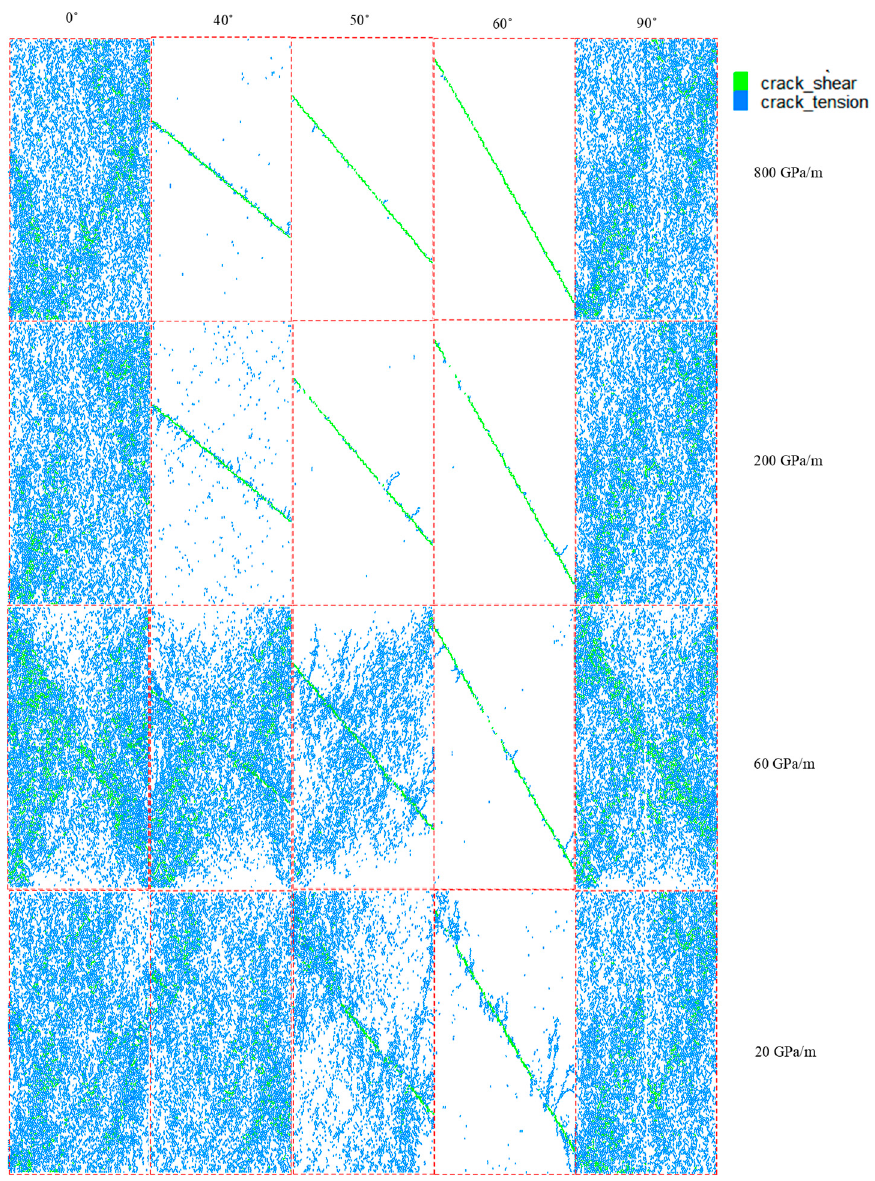
Figure 9. Accumulated micro-cracks of rock mass model with various joint elasticity.